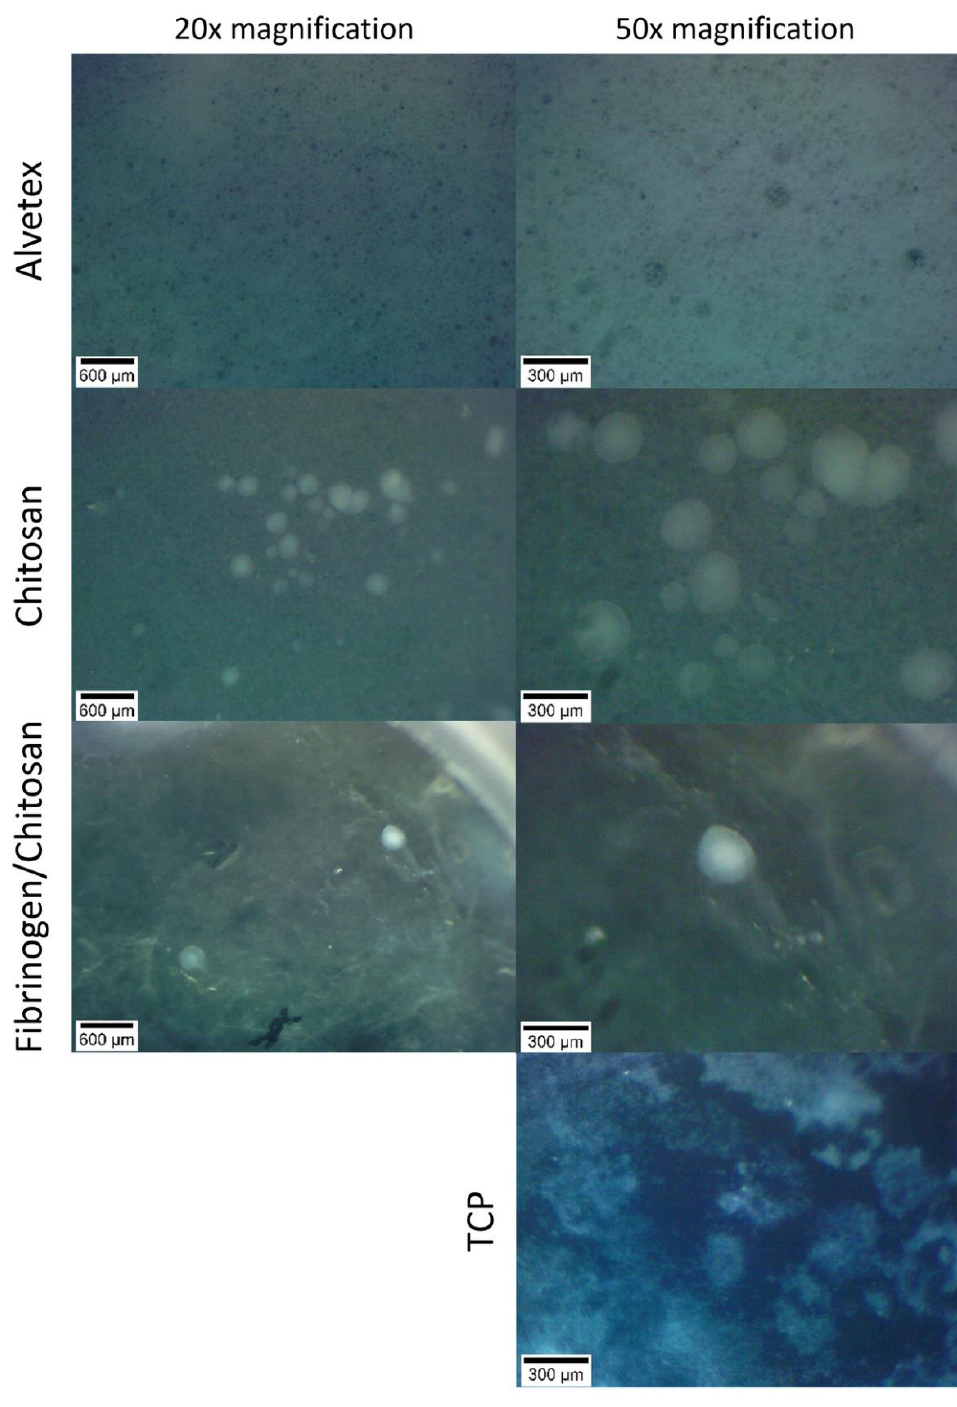
Figure 3. Stereomicroscope images of pseudoislets on 3D scaffolds at day 37.